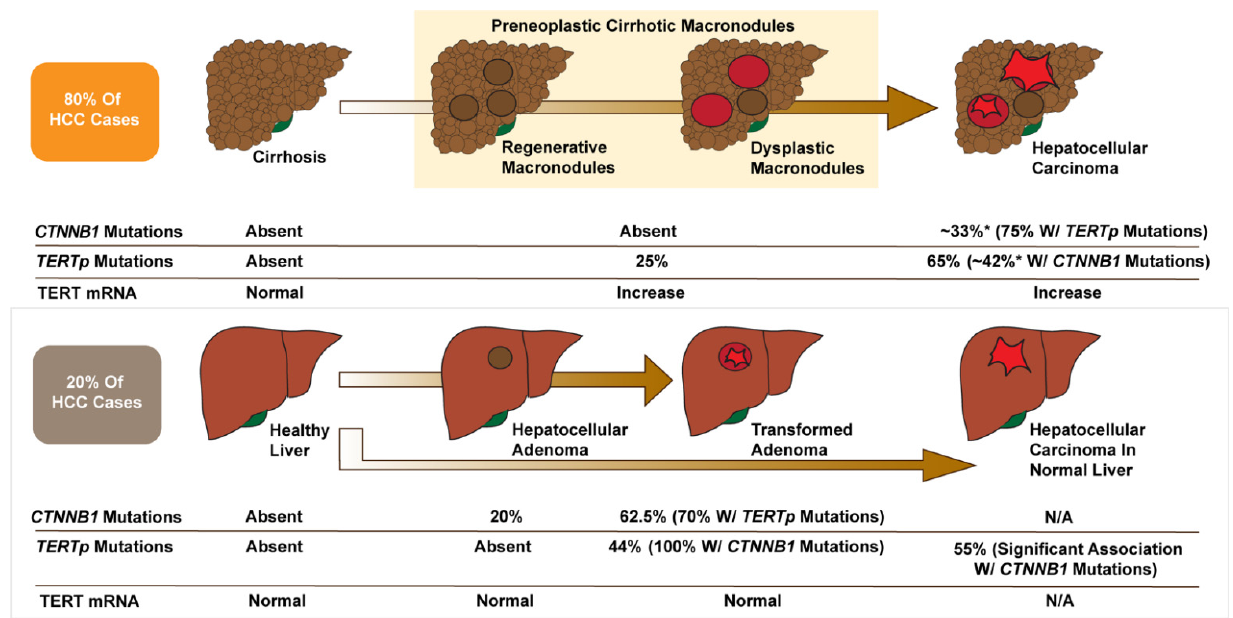
Figure 3. Multi-step hepatocarcinogenesis: Interplay of TERTp and CTNNB1 mutations. Adapted from Nault et al. and Pinyol et al. [5,105]. TERTp mutations (found in the majority of HCC cases) are the earliest somatic alteration found in preneoplastic cirrhotic lesions and are associated with increased TERT transcription. Activating CTNNB1 mutations and TERTp mutations show high concordance in HCC, and CTNNB1 mutations are enriched in later stages of malignancy, indicating their role as cancer drivers. In HCA, TERTp mutations might flip the switch from benign β -catenin-linked tumorigenesis to malignant HCC. *: Mutation incidence in total HCC samples irrespective of cirrhotic or non-cirrhotic background. N/A: Not applicable as not reported separately in large-scale sequencing studies.